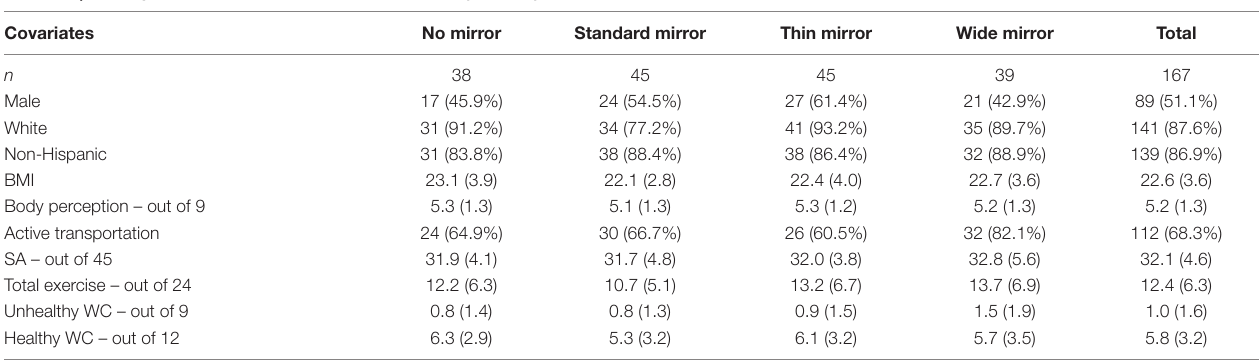
TaBle 1 | Descriptive statistics for stair use covariates ( N = 167). covariates no